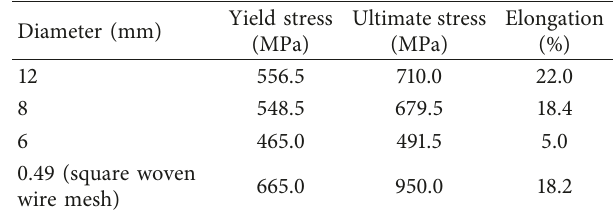
Table 2: Properties of reinforcement steel bars.